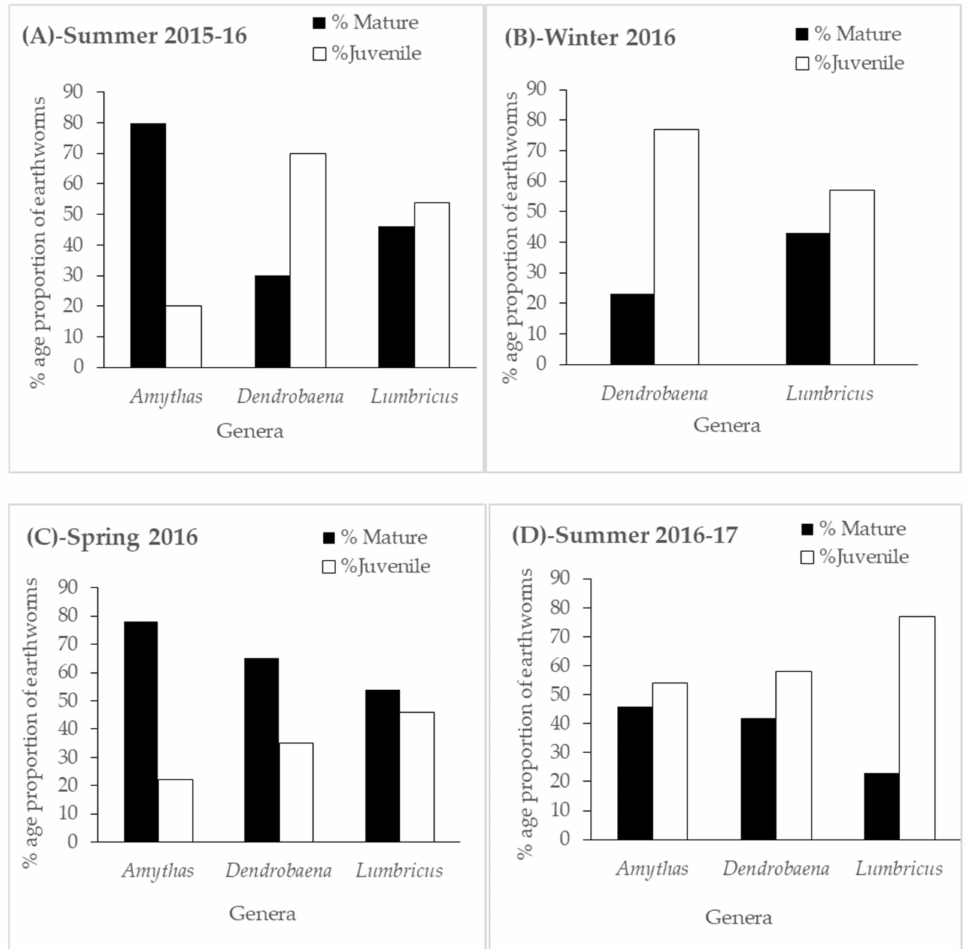
Figure 1. Genus and age proportions of earthworms sampled in summer 2015–2016 ( A ), winter 2016 ( B ), spring 2016 ( C ), and summer 2016–2017 ( D ) at the UFH research